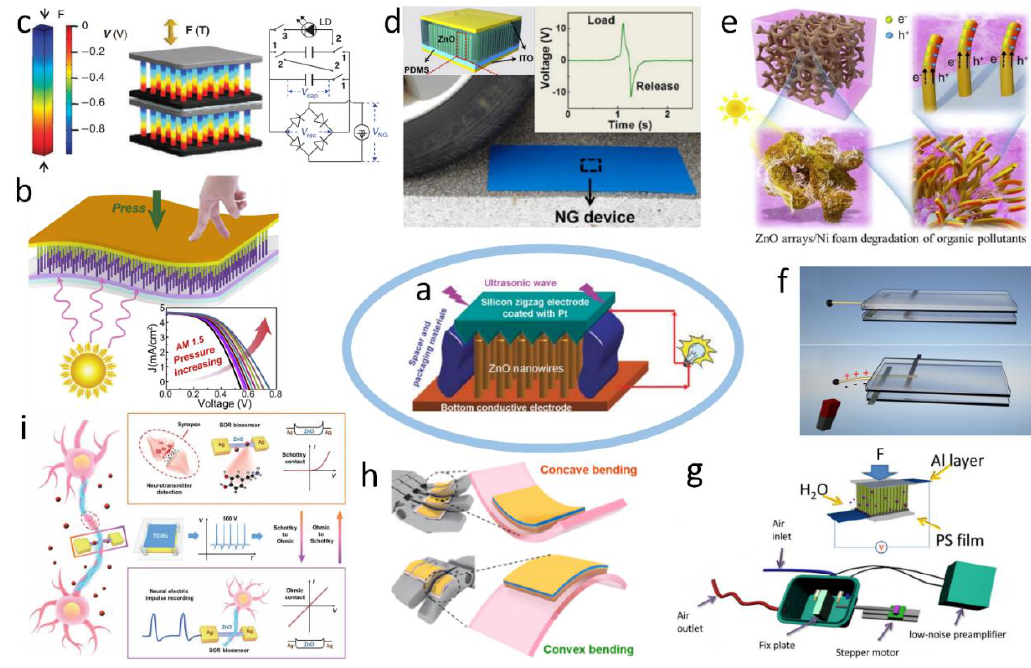
Figure 6. Self-powered sensors based on PENGs. ( a ) Schematic diagram of a PENG. Reproduced with permission [27]. Copyright 2007, American Association for the Advancement of Science. ( b ) Schematic